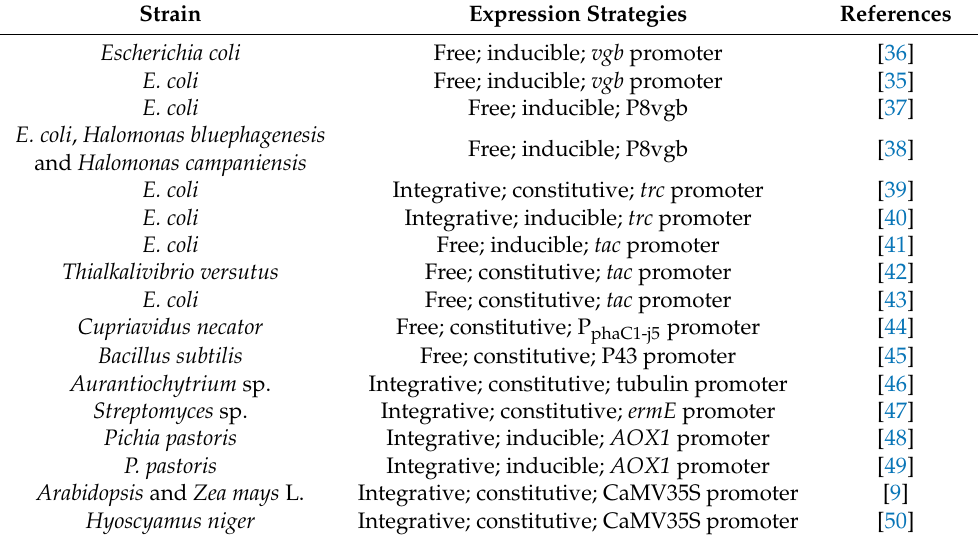
Table 2. The strategies of VHb expression.